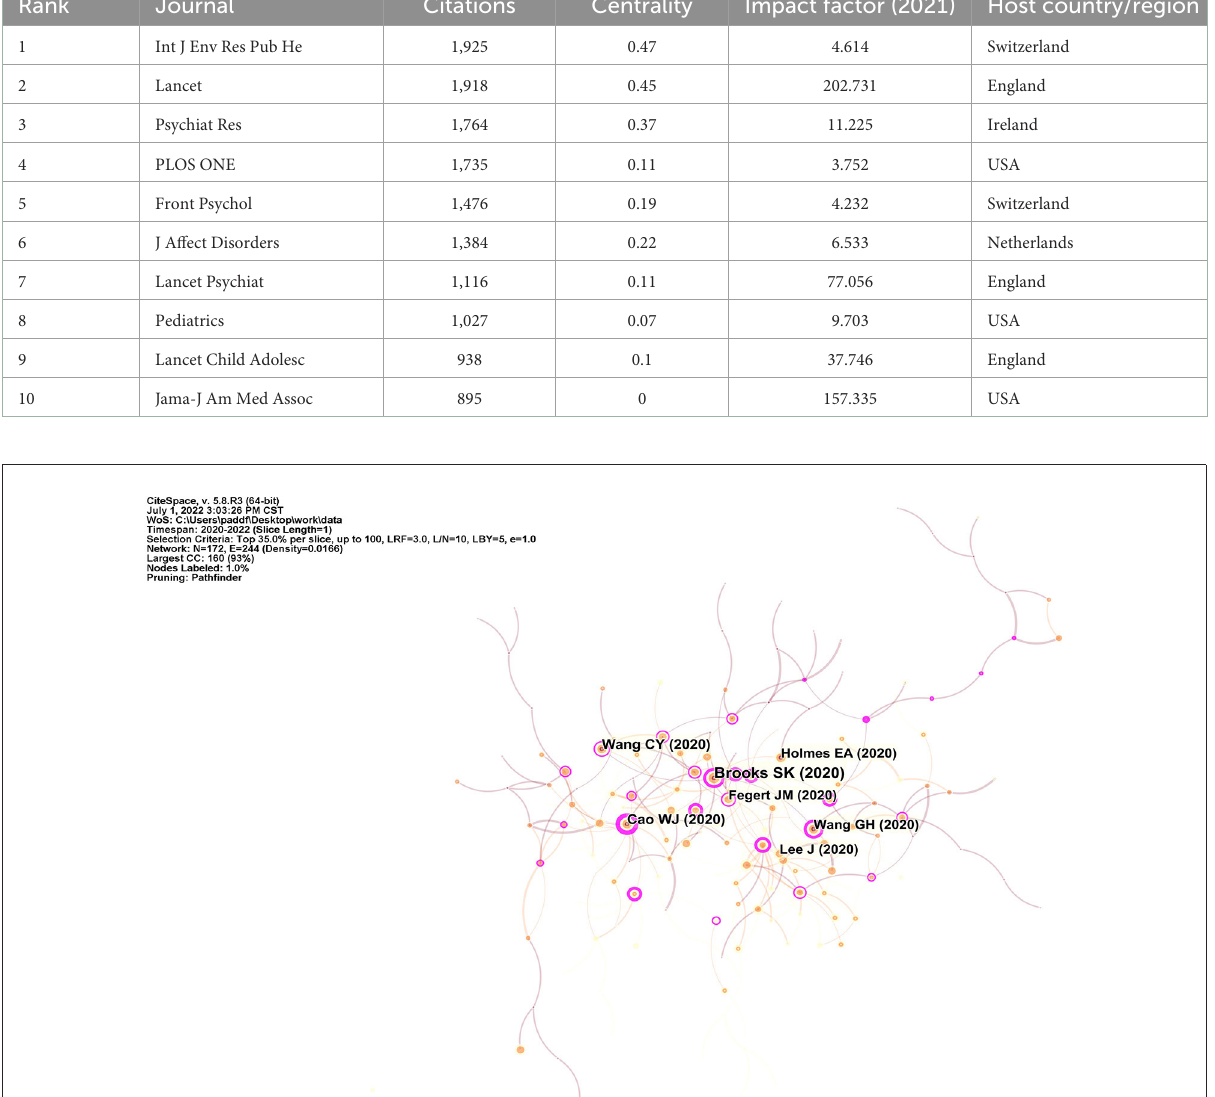
FIGURE6 Visualization map of co-citation documents. Nodes refer to citations, and links represent co-citations between different